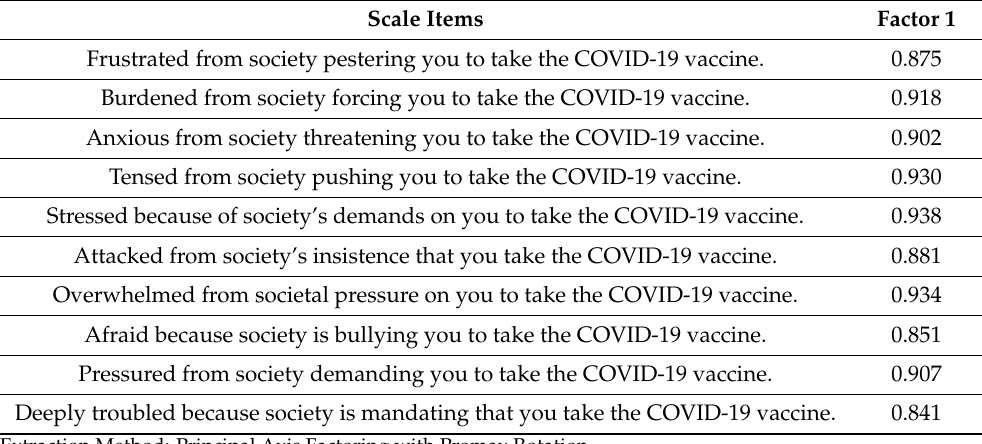
Table 2. Corrected item–total correlations. Scale Items Mean SD